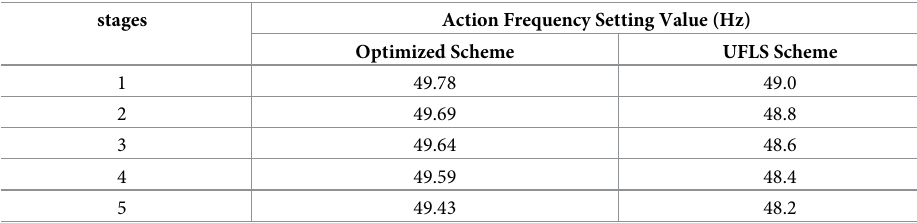
Table 12. Comparison of two schemes (Case